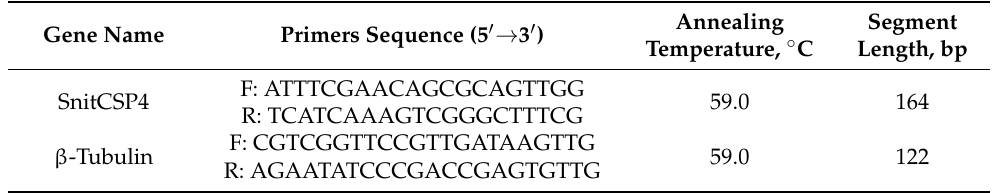
Table 1. Primers used in qPCR.